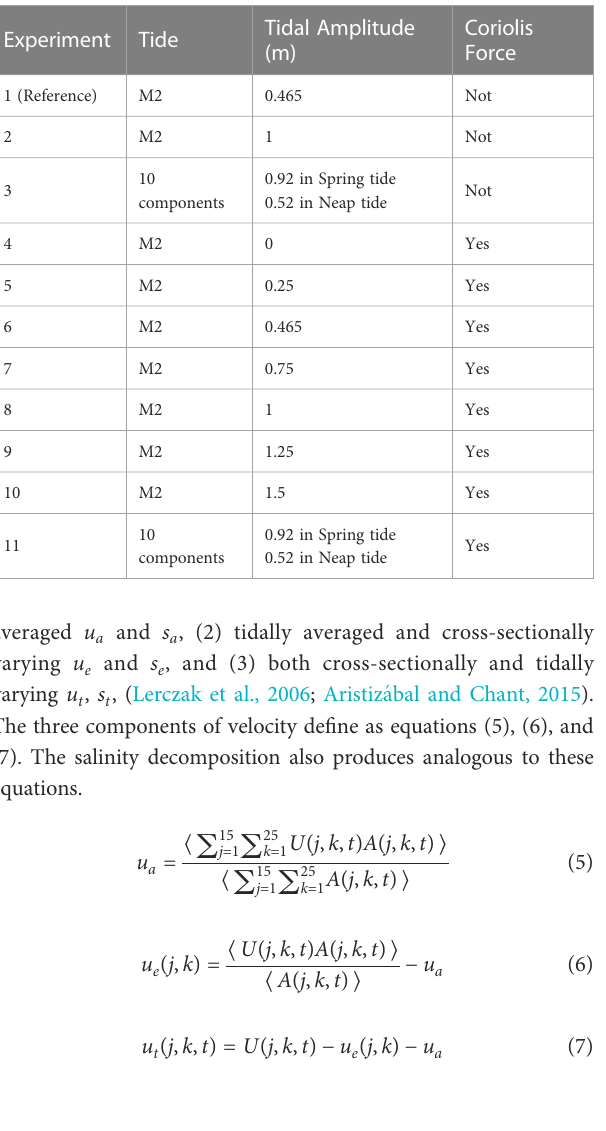
TABLE 1 Summary of the idealized salt-plug estuarine experiments.